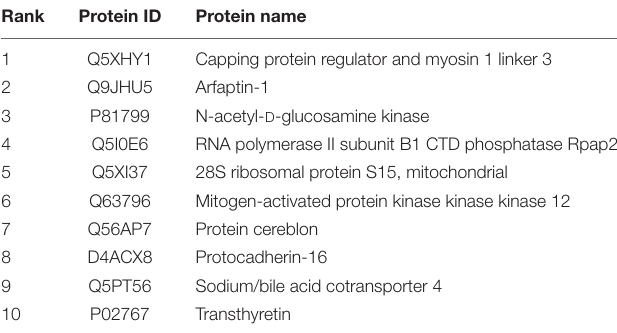
TABLE 1 | Top 10 abundance proteins in T2( + )